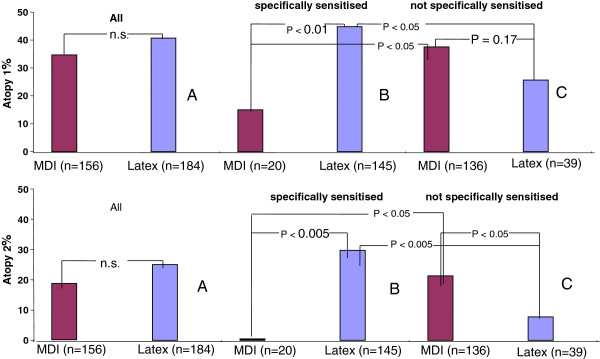
I: Percentage of atopy grade 1 in the latex and MDI subgroups: (A – all; B – specifically sensitized; C – not specifically sensitized). Healthcare workers sensitized to latex were significantly more frequently atopic than non-sensitized healthcare workers. The converse relationship was found for MDI workers. II: Percentage of atopy grade 2 in the latex and MDI subgroups. Differences between occupational subgroups were more pronounced for atopy grade 2, e.g. none of the 20 MDI-sensitized workers and only 8% of the non-sensitized latex workers were designated atopy grade 2.